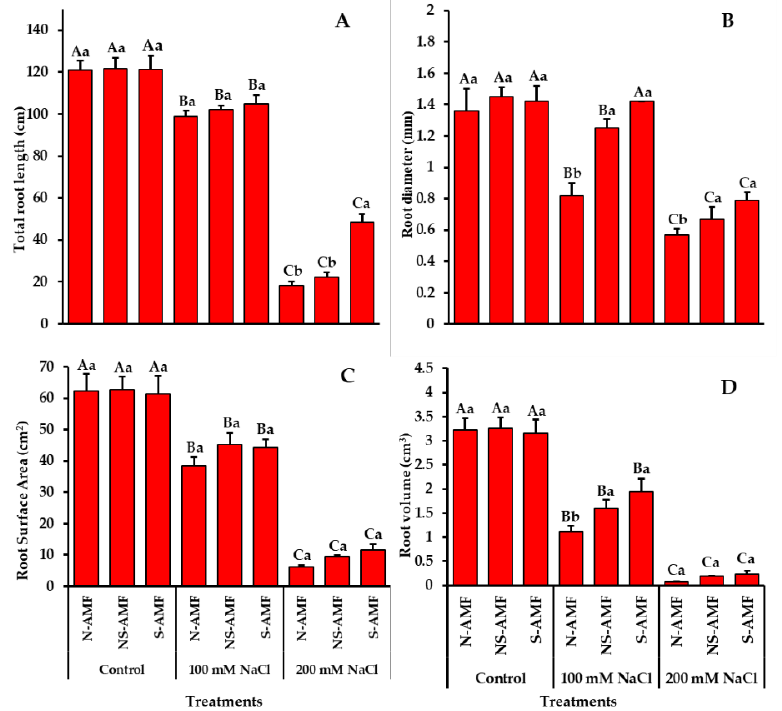
Figure 4. Effect of AM symbiosis (S-AMF and NS-AMF) on growth parameters such as total root length ( A ), root diameter ( B ), root surface area ( C ), and root volume ( D ) of L. scindicus plants cultivated under different salinity levels. Capital letters indicate the significance of the salinity effect, while small letters indicate the effect of AM symbiosis at p = 0.05 (Tukey’s HSD test).